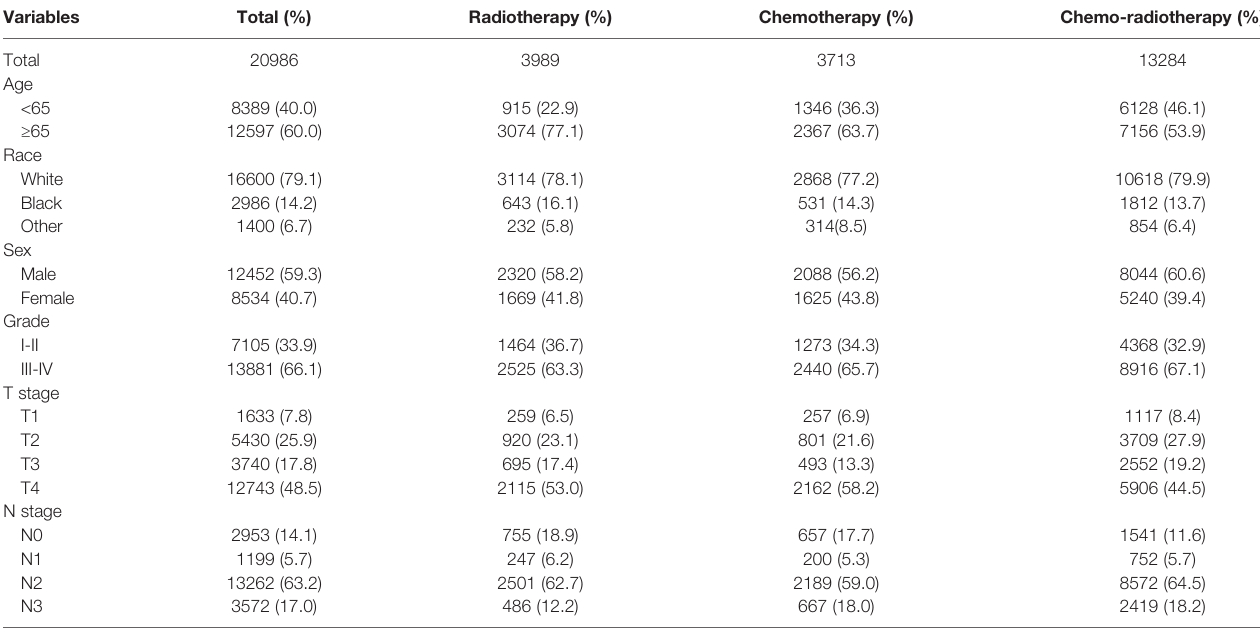
TABLE 1 | Baseline characteristics of patients with unresected stage III non-small cell lung